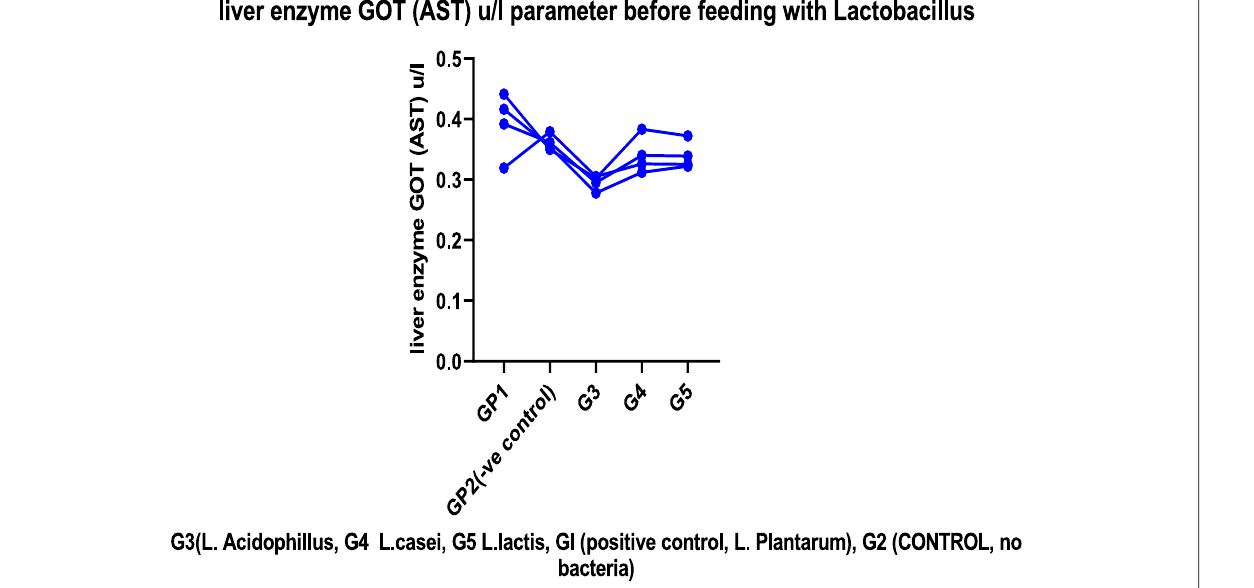
Fig. 6 liver enzyme GOT (AST) μ /l parameter before feeding with Lactobacillus